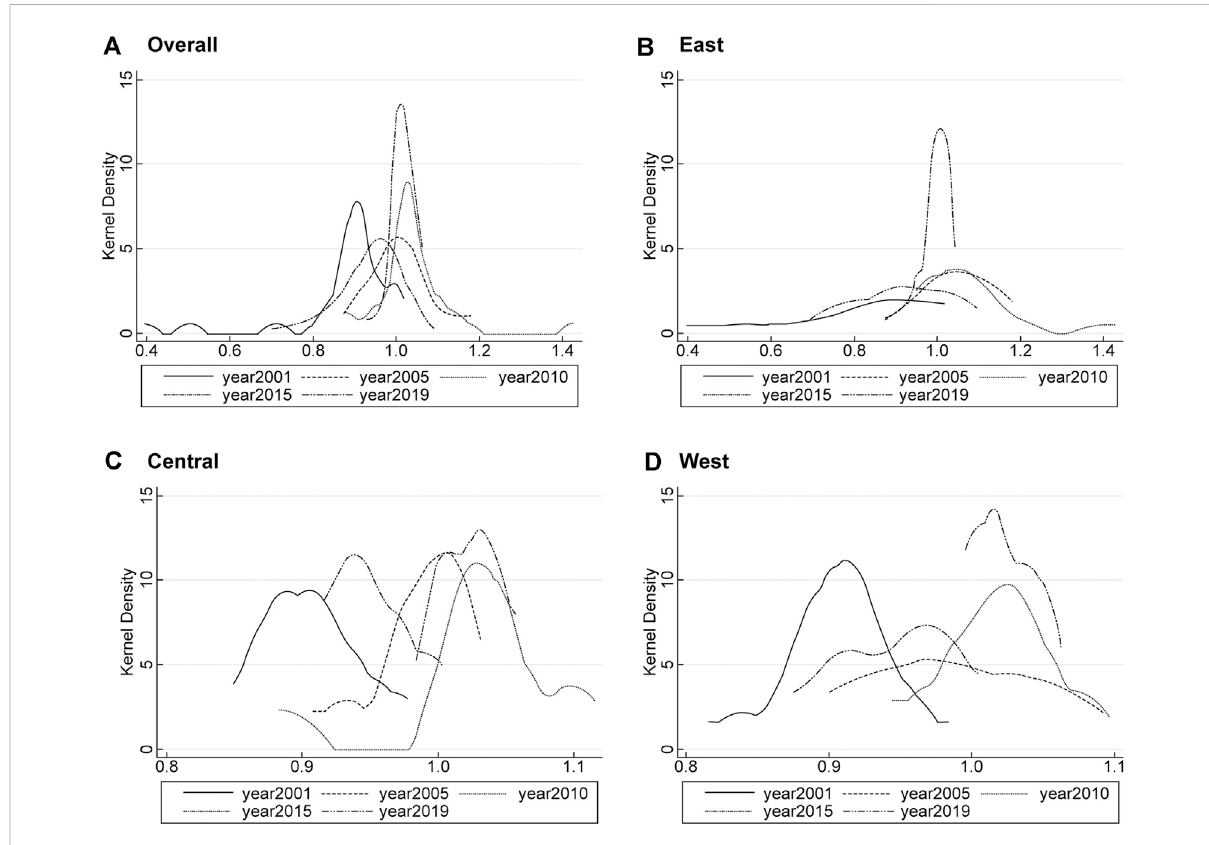
FIGURE 2 Temporal evolution of the national and regional GTFP distributions of China. Notes: (A) Overall temporal evolution; (B) Temporal evolution of the east; (C) Temporal evolution of the central; (D) Temporal evolution of the